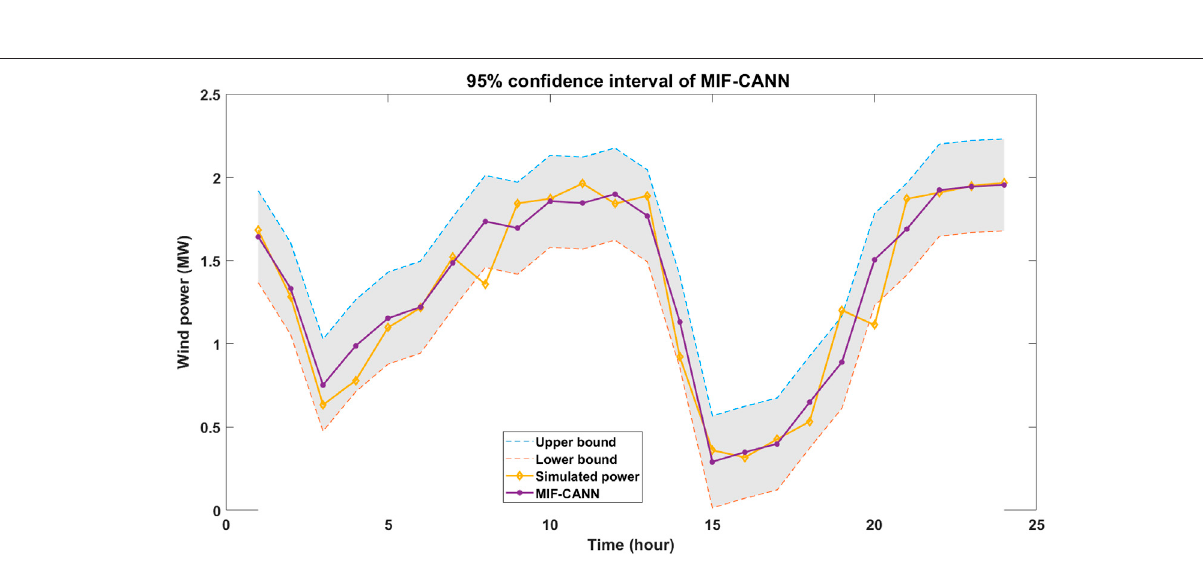
FIGURE 9 | Graph of simulated wind power and forecasted wind power of the ANN-SC-4 model, the ANN-SC-30 model, and the MIF-CANN model.